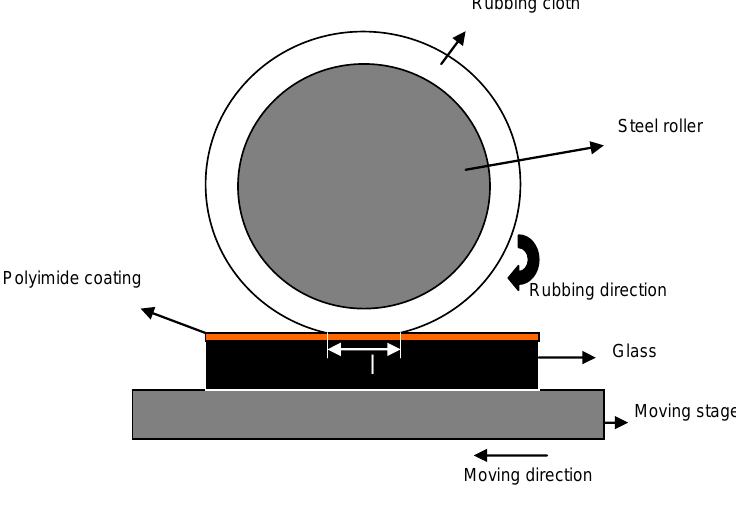
Figure 9. Schematic representation of experimental setup for fabrication alignment layers